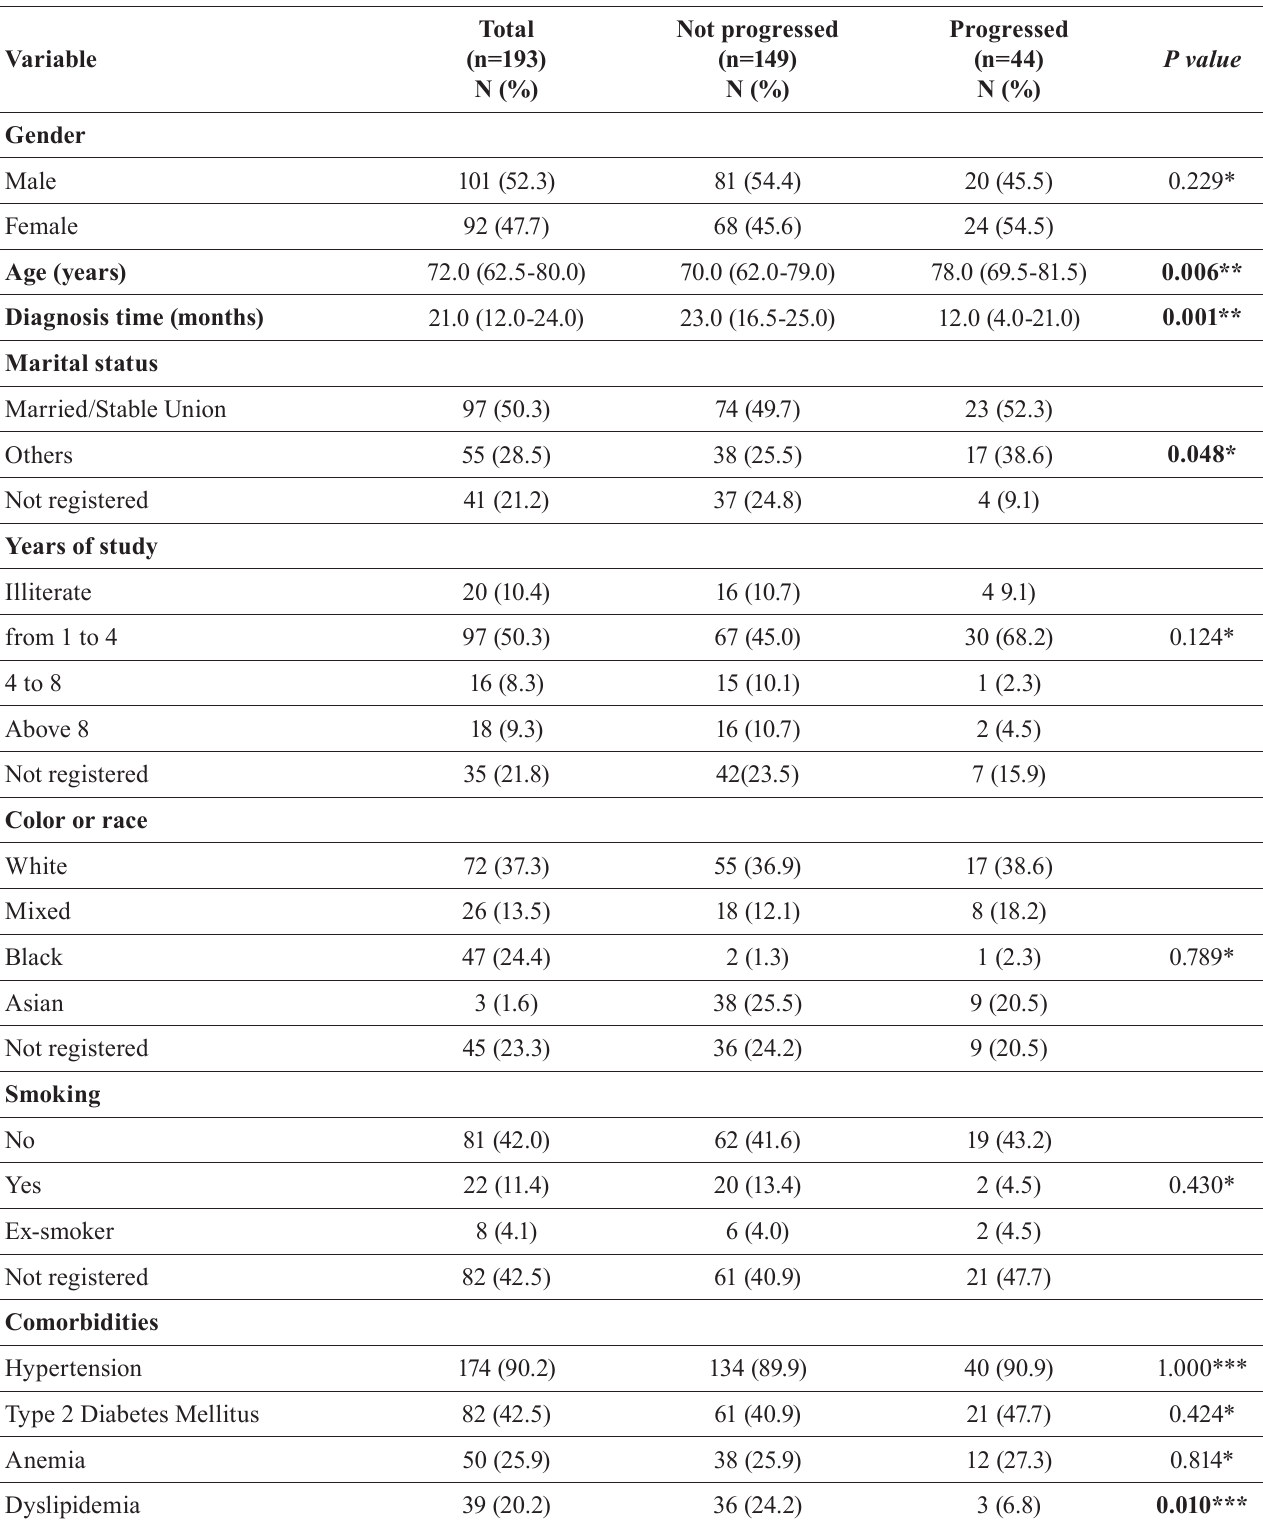
TABLE I - S ociodemographic and clinical characteristics of patients with Chronic Kidney Disease at baseline, attended between 2014 and 2016 at the Municipal Nephrology Outpatient Clinic in Divinópolis (MG), Brazil (n = 193)